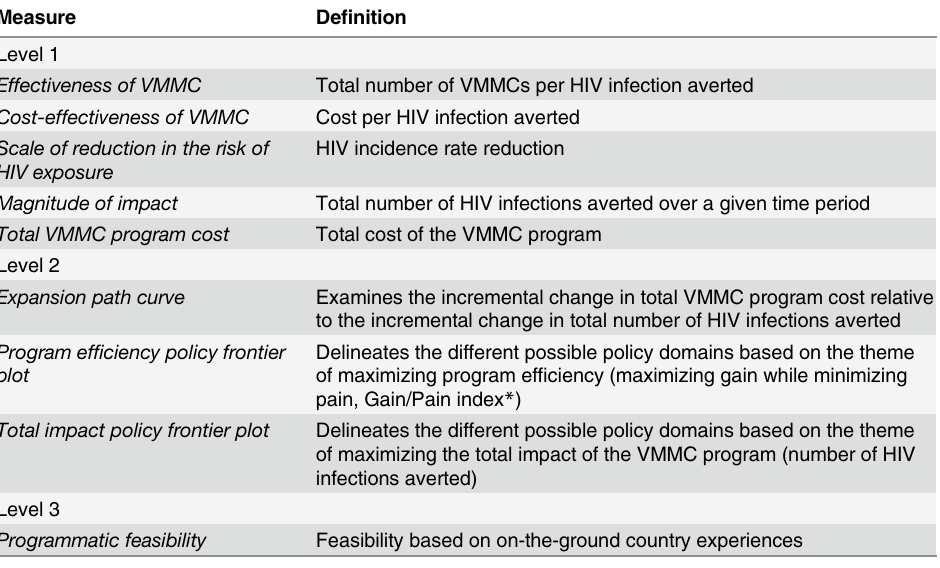
Table 1. Definitions of outcome measures in the three-level conceptual